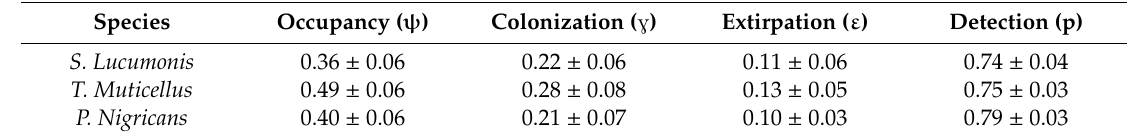
Table 2. Overall occupancy ( ψ ), colonization ( ɣ ), extirpation ( ε ) and detection (p) probabilities (±SE) for Squalius lucumonis , Telestes muticellus and Padogobius nigricans .